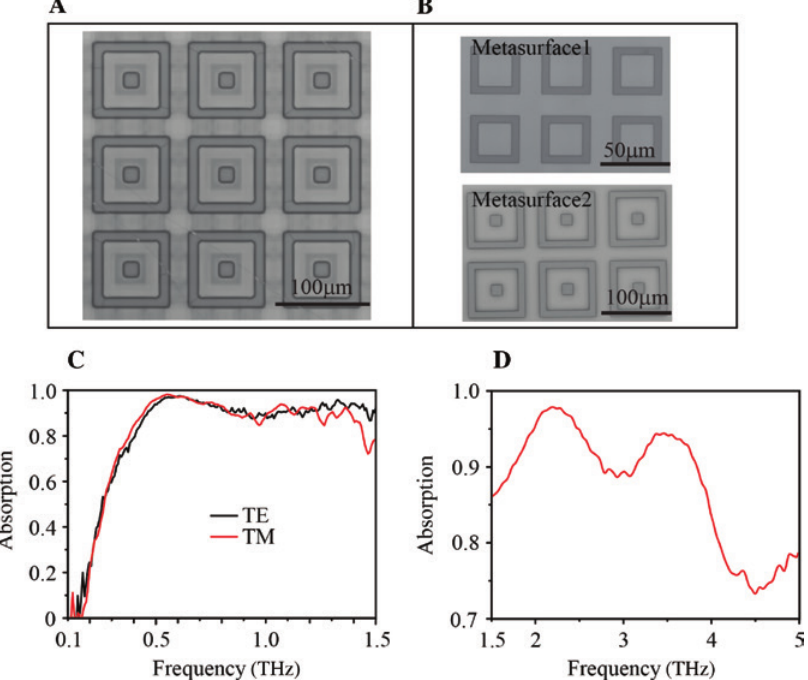
Figure 2: Optical microscopy image and measured absorption of the THz absorber. Optical microscopy images of the whole structure (A) and dual metasurface (B). Absorption measured by THz-TDS in the frequency range from 0.1 to 1.5 THz (C) and measured by FTIR in the frequency range from 1.5 to 5 THz